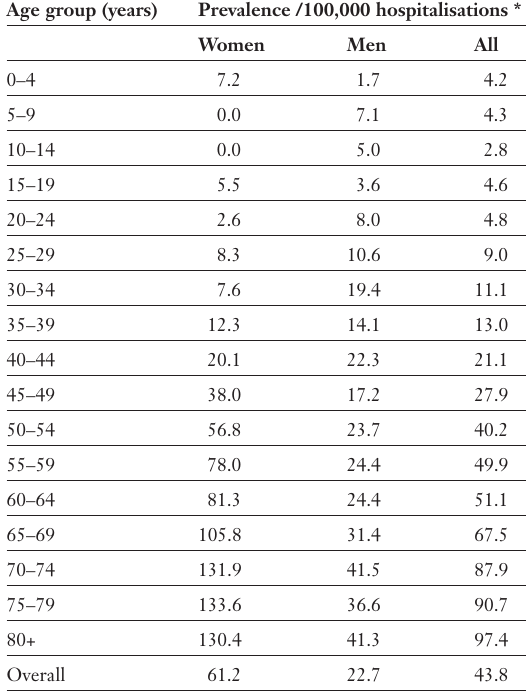
higher in areas of south-west Switzerland than in the rest of the country (data not shown).